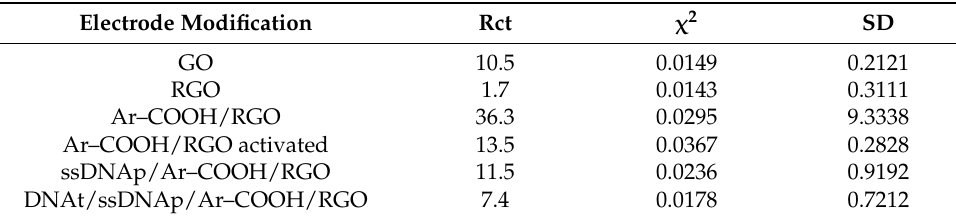
Table 2. Charge transfer resistance values obtained from EIS measurements for the different stages in the electrode modification, along with the quality of fitting χ 2 and standard deviation